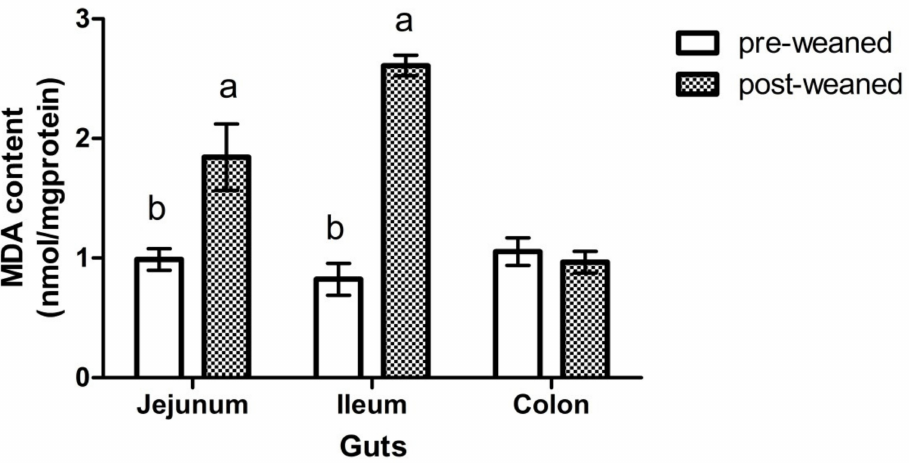
Figure 1. Weaning e ff ects on the content (nmol / mg · protein) of malondialdehyde (MDA) in the colon, ileum, and jejunum of young goats (Exp. 1). a, b Row means that do not have a common superscript di ff er ( p <